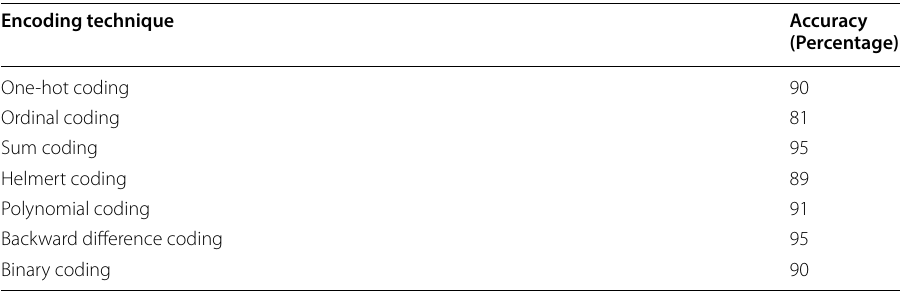
Table 2 Accuracy results reproduced from